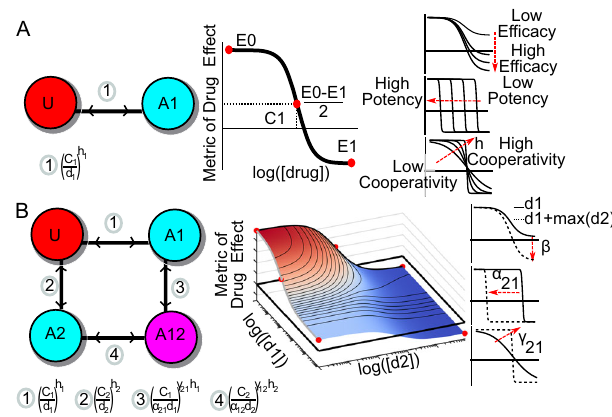
Fig. 1 MuSyC is a mass-action, state-transition model of drug combination synergy. A Two-state transition model for a single drug system. The “ unaffected ” cells are indicated in red with the letter “ U ” , while affected cells are indicated in cyan with “ A1 ” . The traditional equation for fi tting dose-response relationships (middle) is the 4-parameter Hill equation. We derive this equation using the Law of Mass Action from a two-state transition model of drug effect (left). Edge notation is equal to the ratio of states' percent occupancy at equilibrium ( A 1 ) at dose ( d 1 ). The Hill U equation contains parameters measuring a drug ’ s ef fi cacy ( E 0 − E 1 ), potency ( C ), and cooperativity ( h ). Each parameter corresponds to distinct geometric transformations of the dose-response curve (right). B Two-drug model: MuSyC is derived from a four-state state-transition model of combination pharmacology (left) based on the Law of Mass Action and results in a 2D Hill-like equation describing a dose-response surface (middle). Cells affected by both drugs are indicated in the magenta circle and labeled “ A12 ” . Red to blue color gradient on the dose-response surface ranges from no effect (red) to maximum achieved effect (blue). The edge notations (left) refer to the ratio of the connected corners for the (cid:4) (cid:5) ! boundary condition. For example, edge #3 annotation means A 12 A 1 when d 2 → ∞ . Beyond the parameters of the single Hill equation, the 2D Hill equation has additional parameters ( β , α , γ ) corresponding to distinct transformations of the dose-response surface (right) (Video S1). These transformations describe changes in a single drug ’ s ef fi cacy, potency, and cooperativity due to the combination, and, therefore, are interpreted as synergistic ef fi cacy ( β ), synergistic potency ( α ), and synergistic cooperativity ( γ ). There are two values for α and γ because each drug can independently modulate the potency and cooperativity of the other 6,7 (edge 3 vs. edge 4 of the state transition model). In contrast, the single β parameter describes the percent increase in maximal effect due to both drugs (effect E 3 at A 12). See Fig. S1 for MuSyC extension to three drugs.